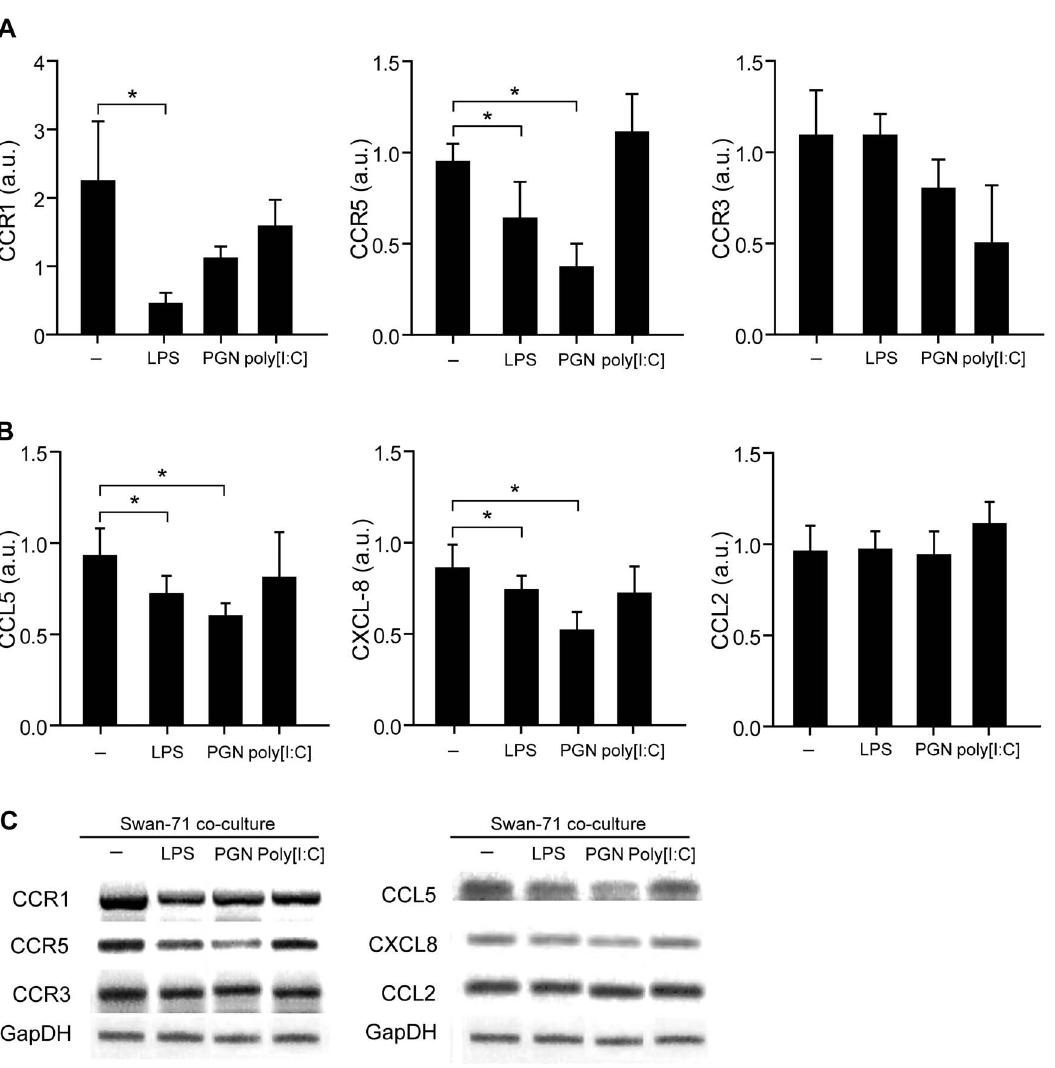
Figure 4. Trophoblast cells primed with PAMPs stimuli condition chemokine and chemokine receptor expression on maternal monocytes. Swan 71 cell line at 70% of confluence were cultured in a polystyrene plate in complete DMEM 10% FCS in the absence or presence of LPS (10 m g/ml), PGN (10 m g/ml), or poly [I:C] (10 m g/ml) and 0.4 um pore-insert were added containing CD14 + cells. After 24 hours, cells were recovered from the upper compartments and the expression of ( A ) CCR1, CCR5 and CCR3; ( B ) CCL5, CXCL8, and CCL2 were evaluated by RT-PCR and normalized to GAPDH expression. Results are expressed as arbitrary units (a.u) (mean 6 SEM) from 6 independent experiments using different fertile women (*p , 0.05 Friedman test followed by Dunn’s post-test). ( C ) Representative amplification bands from 6 independent